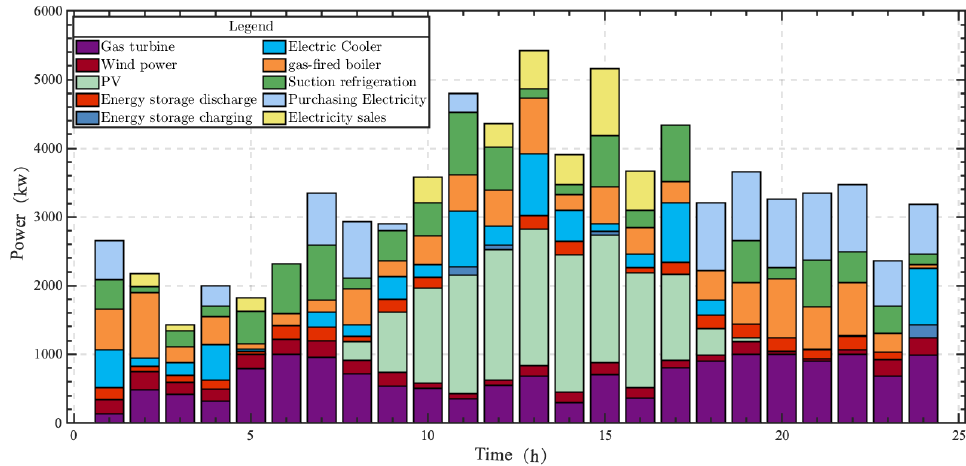
Figure 8. Volume of tradable electricity and operation of electrical units with the robust strategy.